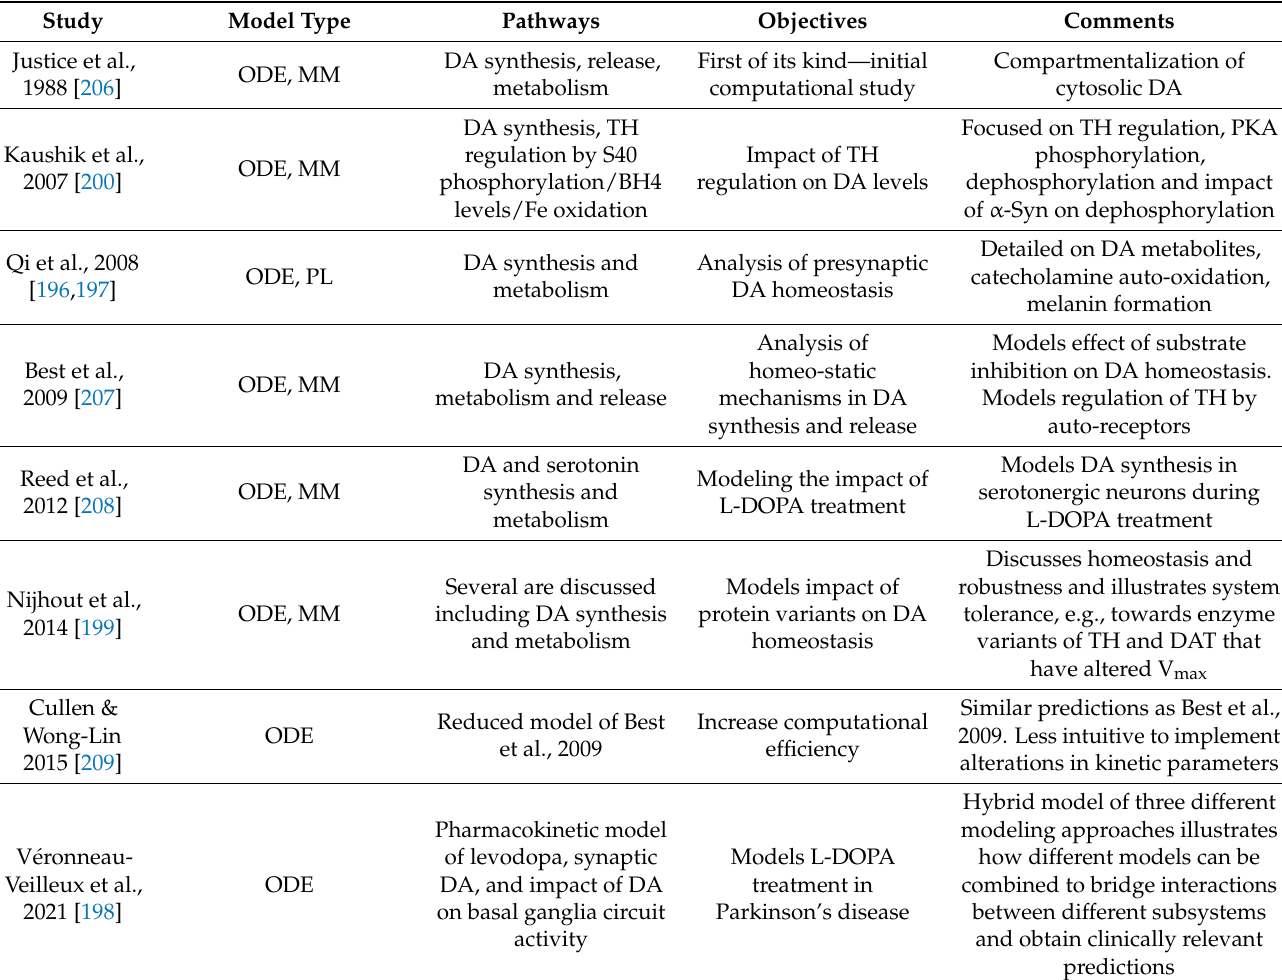
Table 1. A selection of interesting mathematical modeling studies of catecholamine synthesis and metabolism. Study Model